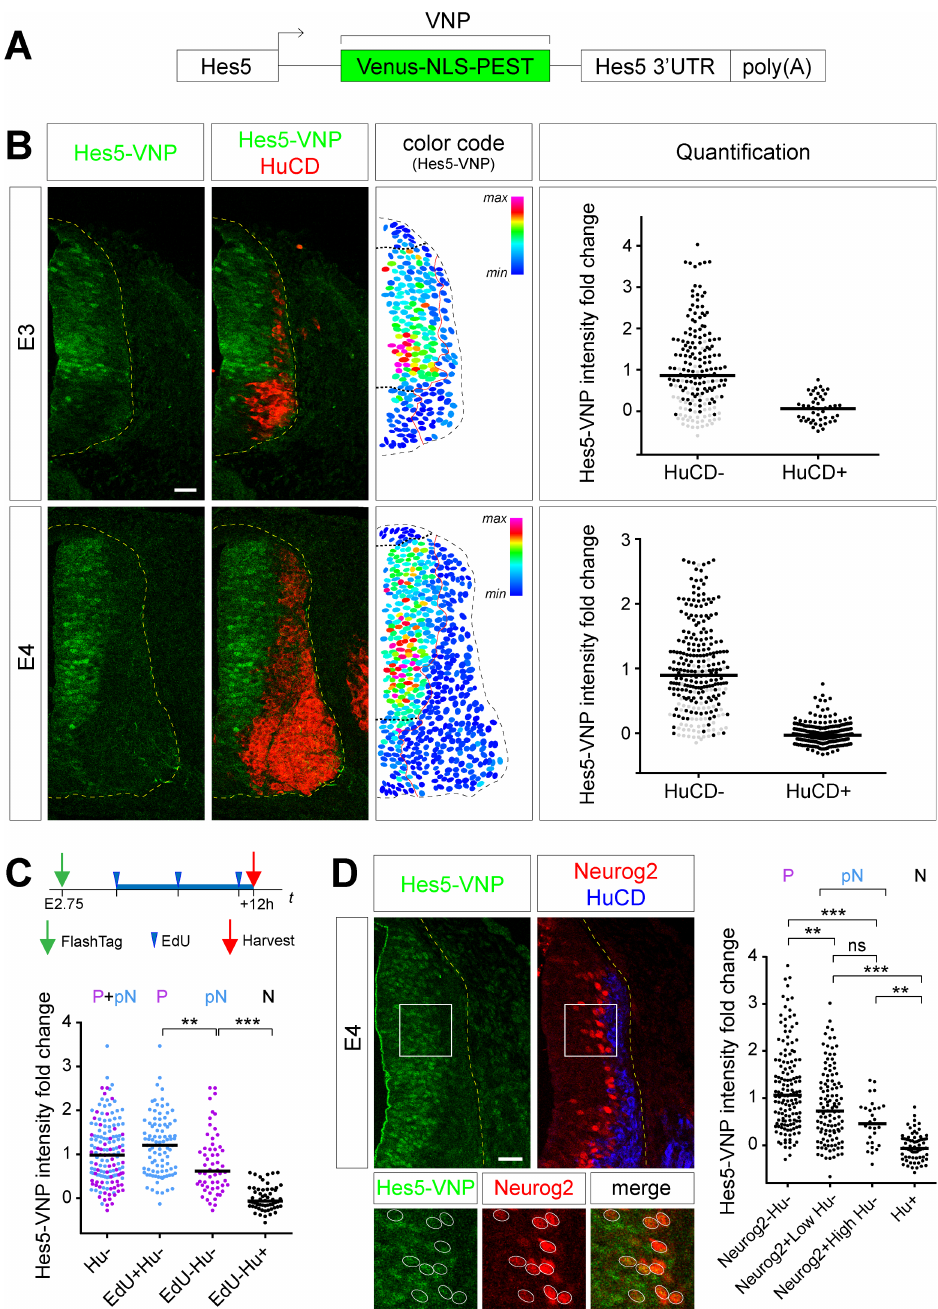
Fig 1. Notch signaling is maintained in prospective neurons. (A) Schematic representation of the Hes5-VNP sequence that was inserted in the Notch reporter transgenic chick line. (B) Left: Transverse sections of the NT of the Hes5-VNP transgenic line at E3 and E4 immunostained for Venus (green) and HuCD (red) to label neurons. Middle: Color coded map of Hes5-VNP intensity. The red line separates HuCD − from HuCD + cells. The black dotted lines delineate the ventral limit of the roof plate and dorsal limit of the motor neuron domain. Right: Distribution of the Hes5-VNP signal intensity in HuCD − and HuCD + cells. Note that cells within the limits of the black dotted lines of the color code panel were labeled in black in the HuCD − population. (C) Top: Time course of the protocol. Bottom: Distribution of the Hes5-VNP signal intensity in FT + /HuCD − cells. This population is then divided into EdU + (blue) and EdU − (magenta) cells. A minimum of 58 cells collected from four embryos were analyzed for each group. (D) Left: Transverse sections of the dorsal NT in the Hes5-VNP transgenic line at E4 immunostained for Venus (green), Neurog2 (red), and HuCD (blue). Bottom: Enlarged view of the boxed area showing representative examples